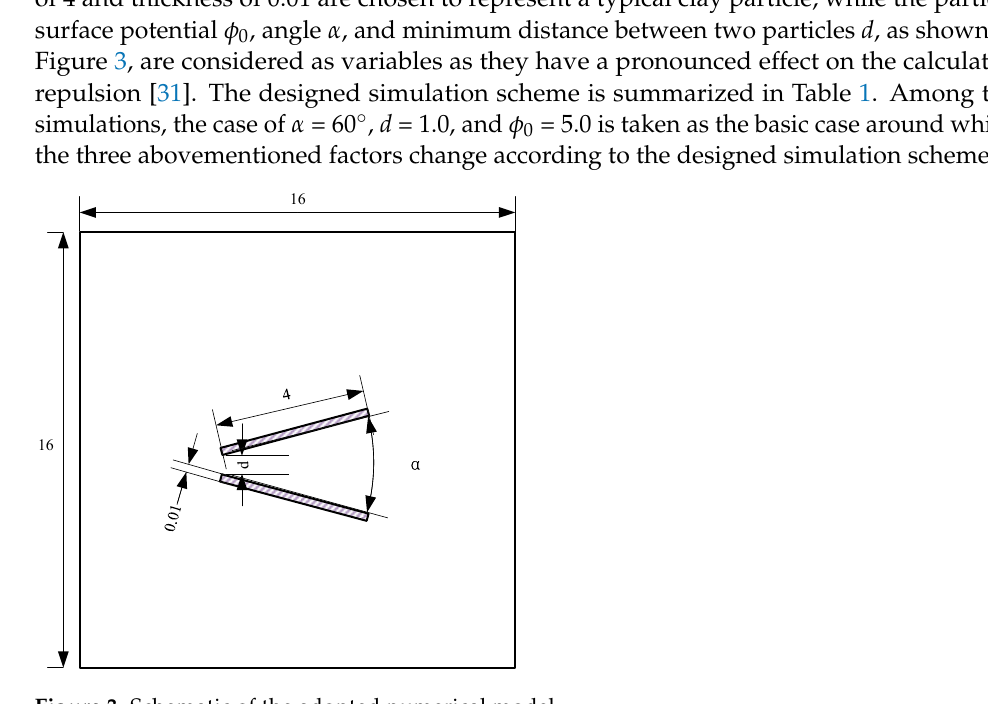
Figure 3. Schematic of the adopted numerical model. Table 1. Scheme of the numerical simulations.